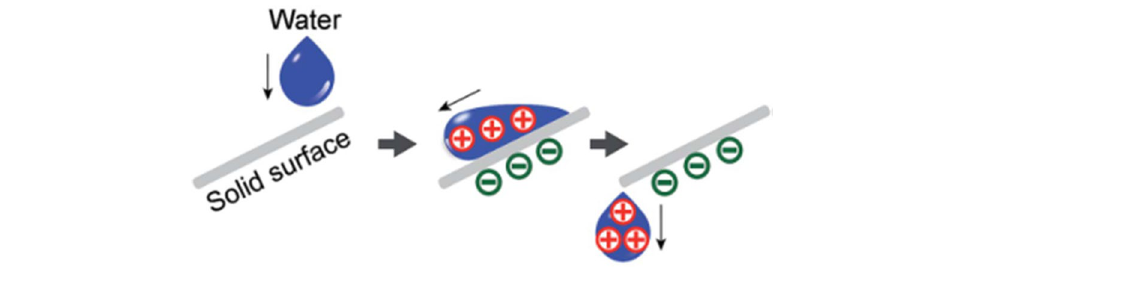
Figure 10. Working mechanism of the solid–liquid